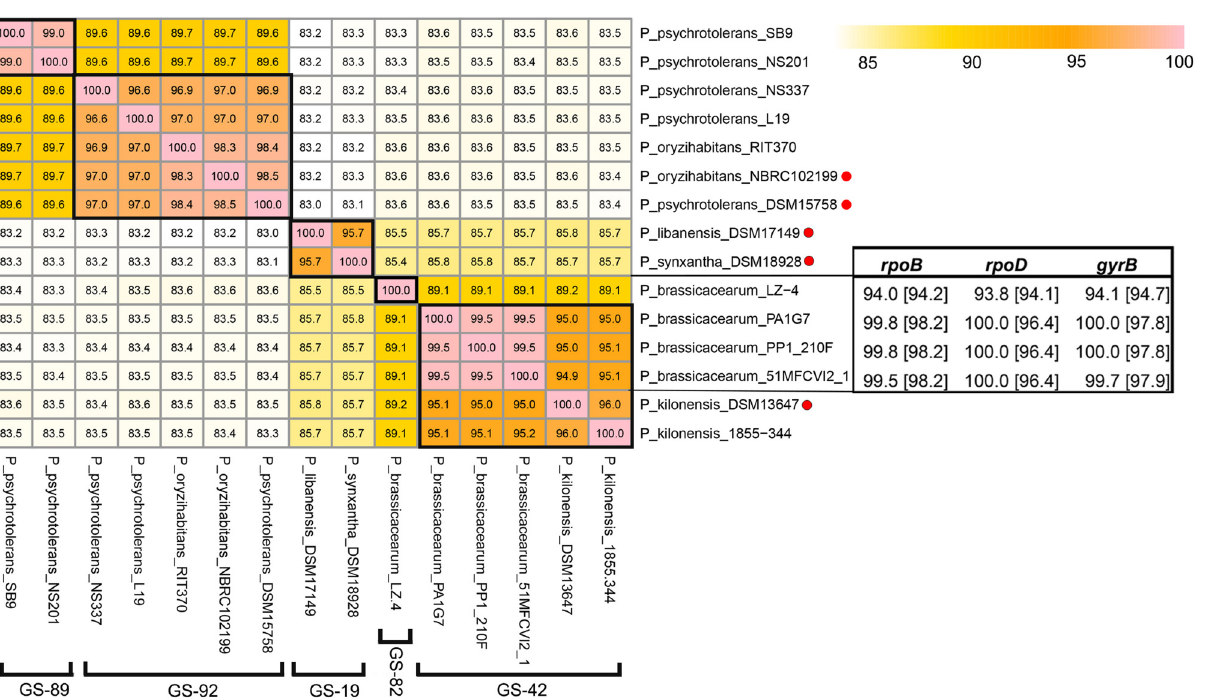
FIGURE 3 | ANIm matrix of 15 Pseudomonas genomes from closely-related species including P. psychrotolerans - P. oryzihanbitans , P. brassicacearum - P. kilonensis, and P. libanensis - P. synxantha . Type strains were indicated with red dots and the genospecies corresponding to each cluster was specified in bracket. Blastn results were expressed in percentage with values in and outside the bracket show percentage identity to the housekeeping genes ( rpoB, rpoD, and gyrB ) of P. kilonensis DSM 13647 T and P. brassicacearum CIP 107059 T , respectively. These two genomes along with whole genome of P. psychrotolerans DSM 15758 T (downloaded in April 2017) were only used to generate the ANIm matrix and were excluded from other analyses.